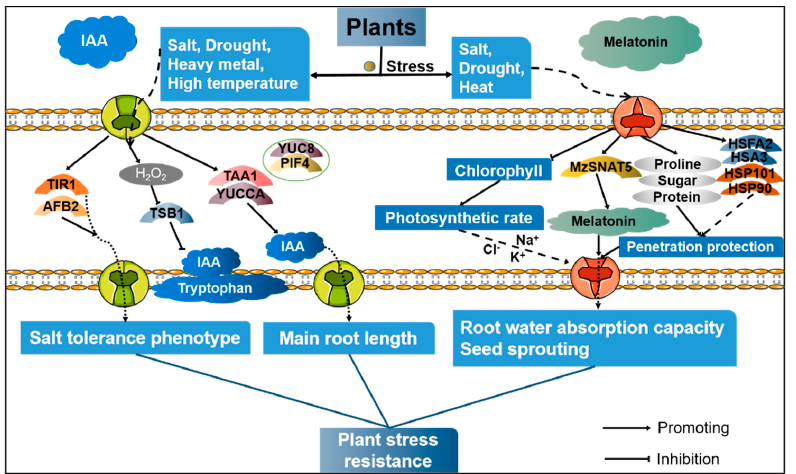
Figure 5. Regulation of melatonin signaling by IAA include key components and transcriptional regulation.